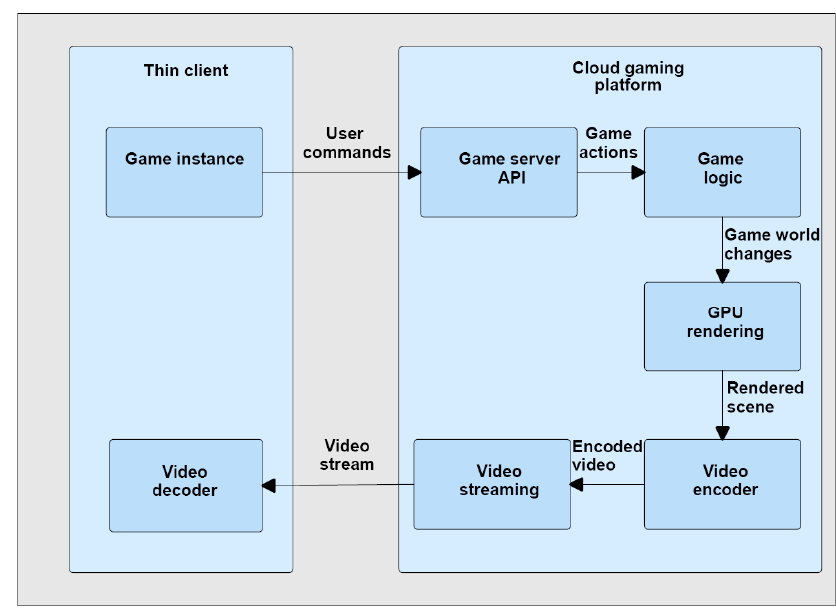
Figure 2. Cloud based game architecture (adapted from Reference [8]).